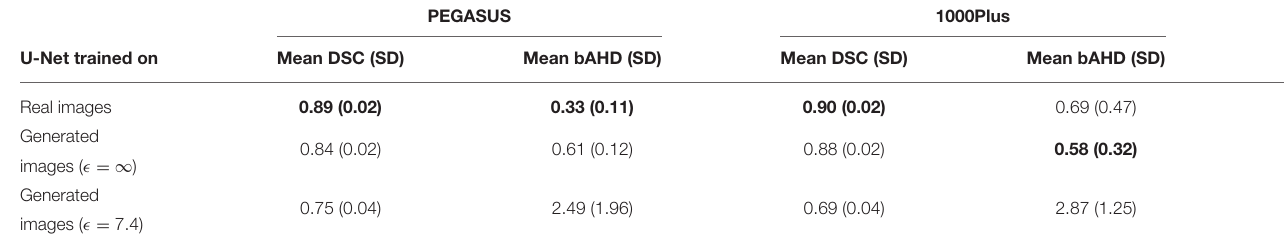
TABLE 1 | Overview of segmentation performances in terms of DSC and bAHD for a U-Net trained on real patient images and generated with and without differential privacy. The best of the three U-Net models is shown in bold for each metric and dataset. The best U-Net with differential privacy guarantees has an ǫ of 7.4. SD stands for standard